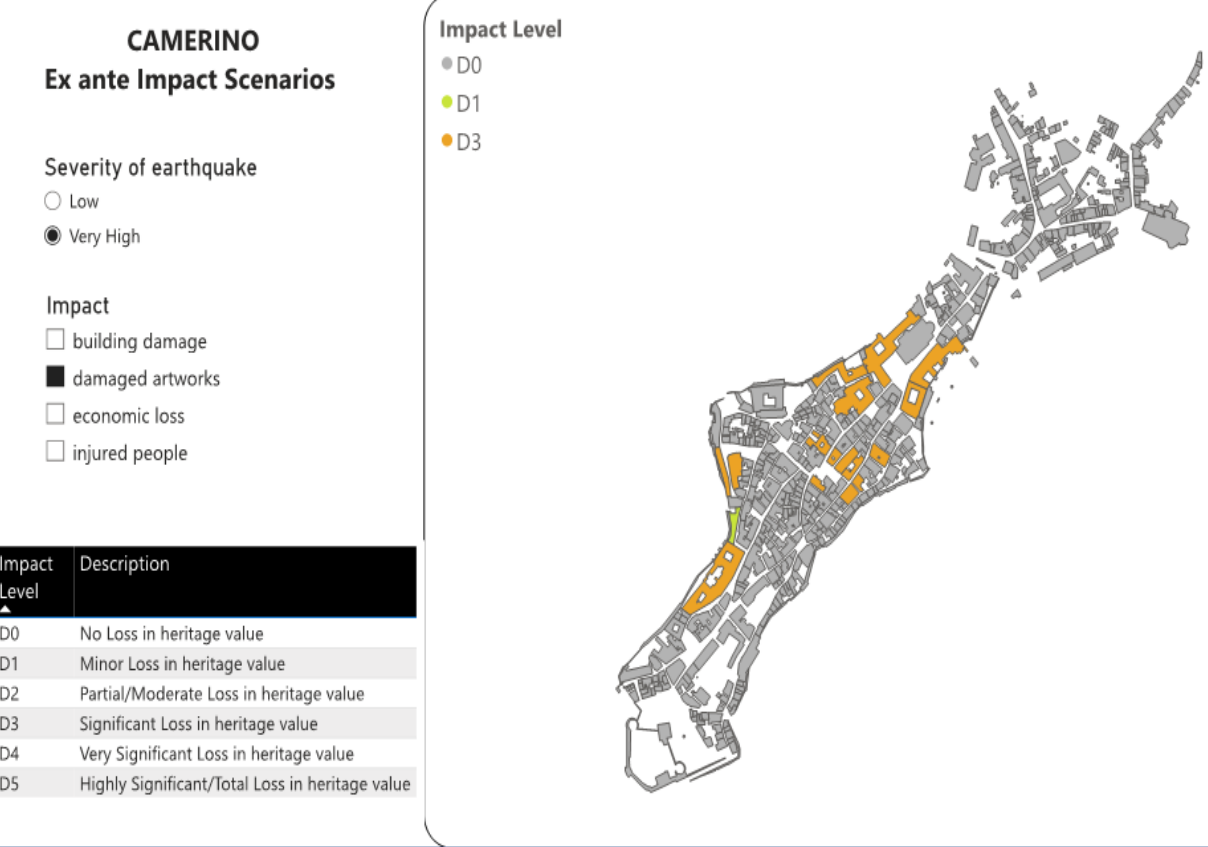
Figure 6. Visualization of ex ante impact scenarios.